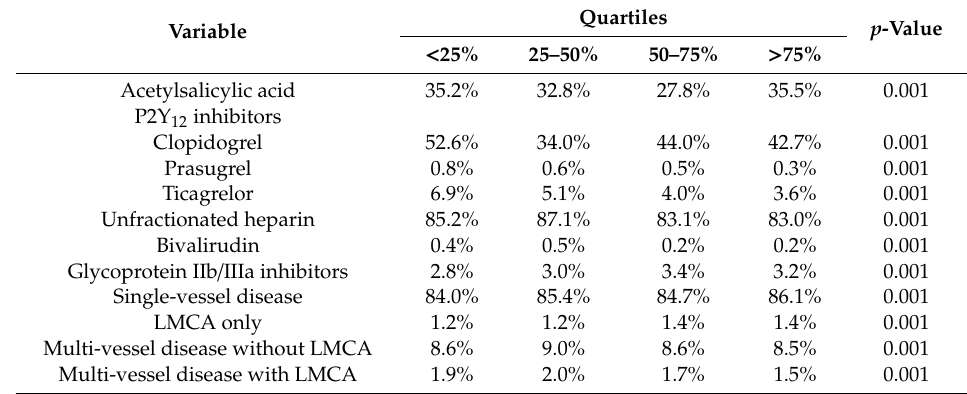
Table 2. Treatment during percutaneous coronary intervention and angiographic characteristic of patients treated by operators divided into quartiles depending on operator’s utilization of radial access site.